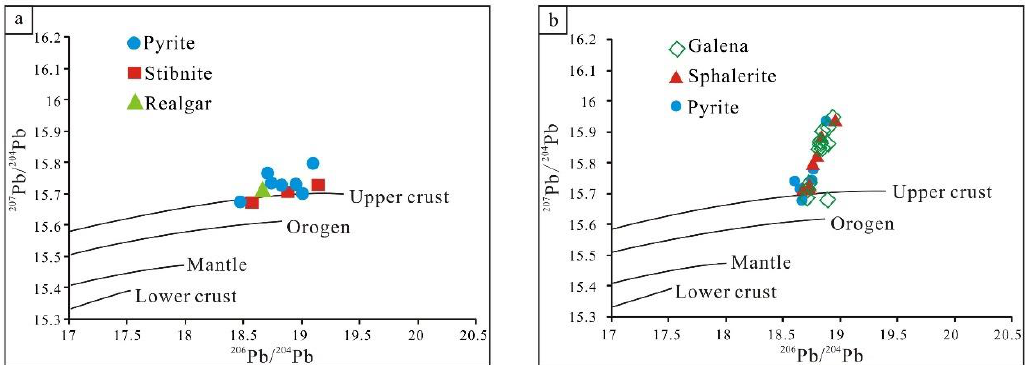
Figure 16. Plot of the Pb isotopic data for the sulfides from the Changkeng – Fuwan Au ( a )-Ag ( b ) deposit; the evolution curves of the upper crust, lower crust, mantle, and orogen are from [111].